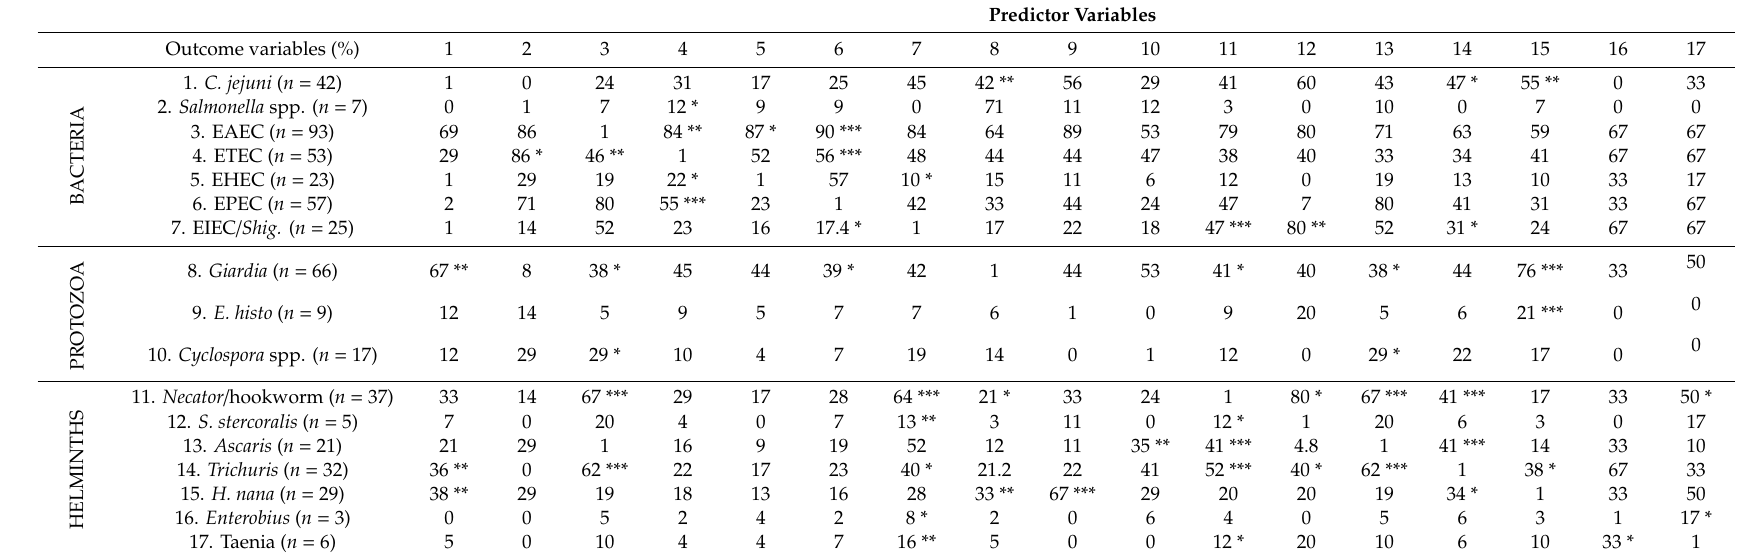
Table 1. Results of the logistic regression for single parasites. Significance: 0 ***, 0.001 **, 0.01 *. C. jejuni = Campylobacter jejuni , EAEC = enteroaggregative E. coli , ETEC = enterotoxin-producing E. coli , EHEC = enterohemorrhagic E. Coli , EPEC = enteropathogenic E. coli , EIEC / Shig. = Enteroinvasive E. coli / Shigella spp., Giardia = G. intestinalis , E. histo = Entamoeba histolytica , Necator = N. americanus , S. stercoralis = Strongyloides stercoralis , Ascaris = A. lumbricoides , Trichuris = T. trichiura , H. nana = Hymenolepis nana , Enterobius = E. vermicularis